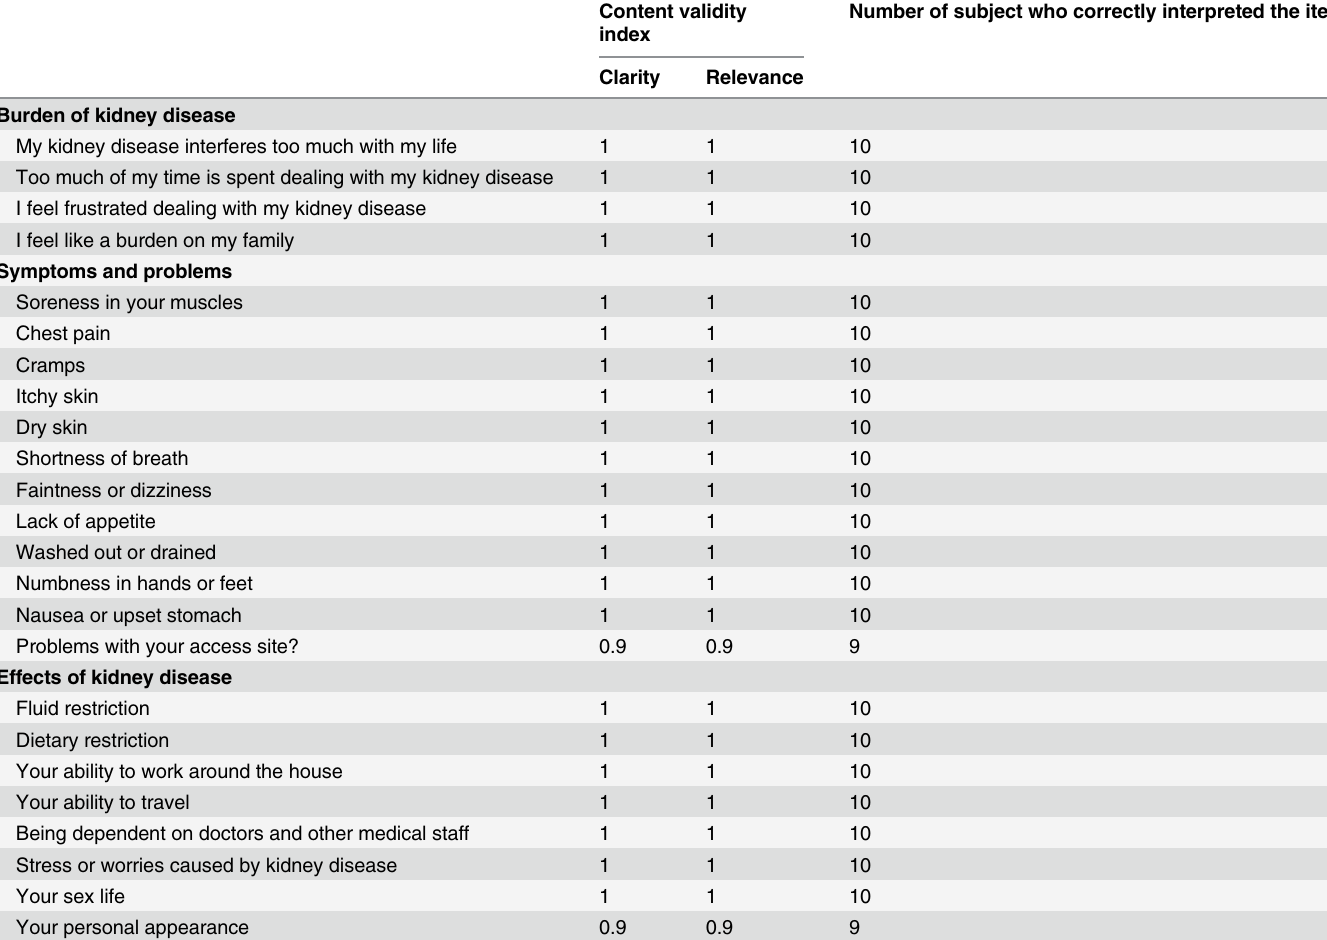
Table 1. Results of cognitive debriefing